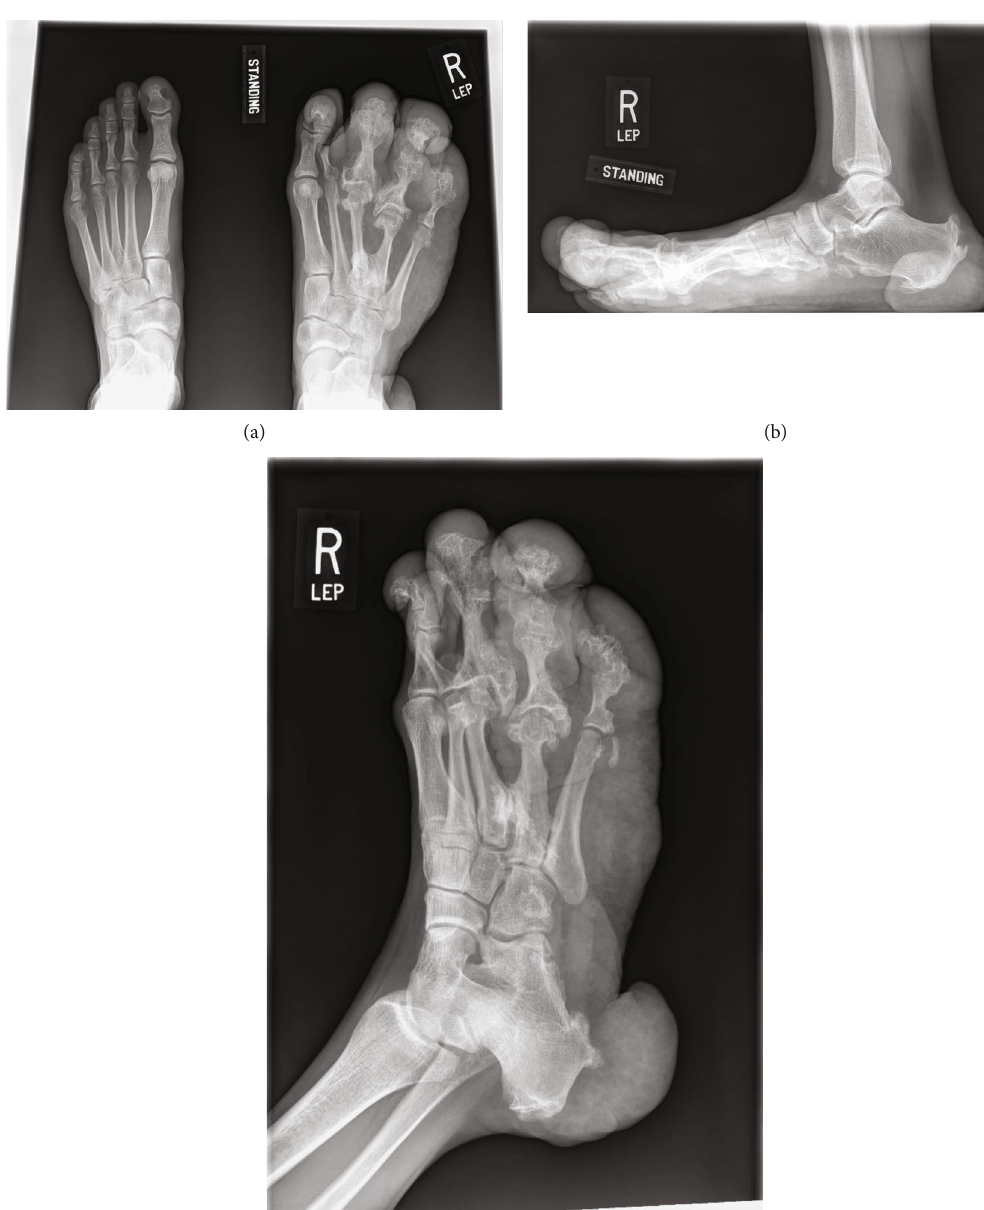
Figure 3: Anteroposterior, lateral, and oblique radiographs of the bilateral feet demonstrating macrodactyly of the right foot involving the second, third, fourth, and fi fth toes with medial deviation of the second ray, pseudoarticulation of the third and fourth metatarsals, and advanced degenerative changes of the third and fourth metatarsophalangeal joints and interphalangeal joints of the second through fi fth toes. Lateral view demonstrates soft tissue enlargement of the calcaneal soft tissues and large plantar and posterior calcaneal